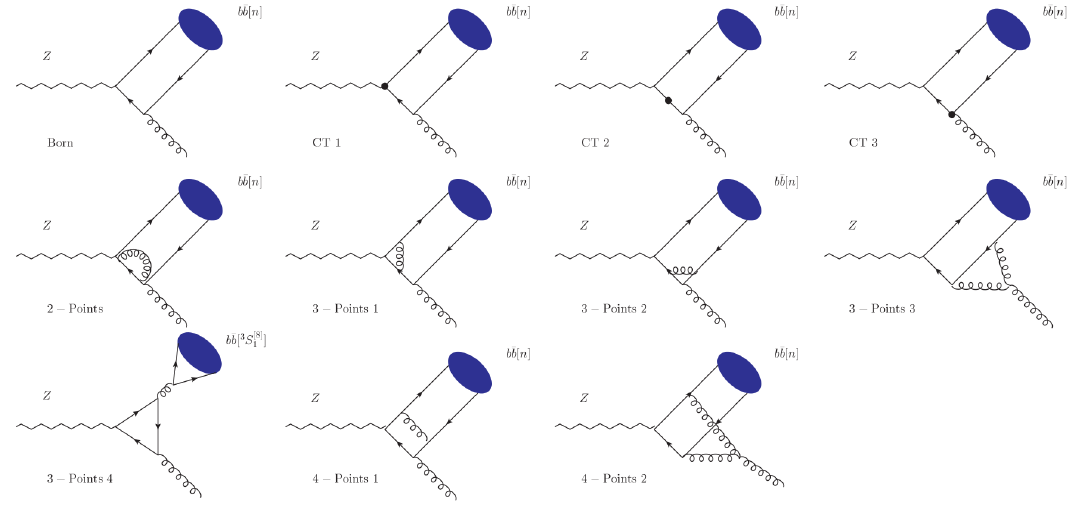
Figure 1 . Typical diagrams for the virtual corrections to Z → b ¯ b [ n ]+ g . n = 1 S [8]